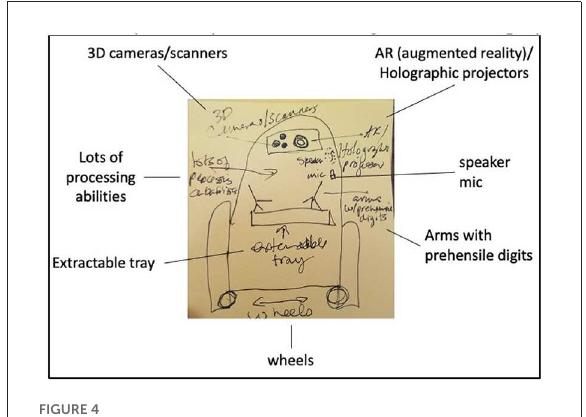
FIGURE4 P3 US drew a robot concept and indicated its